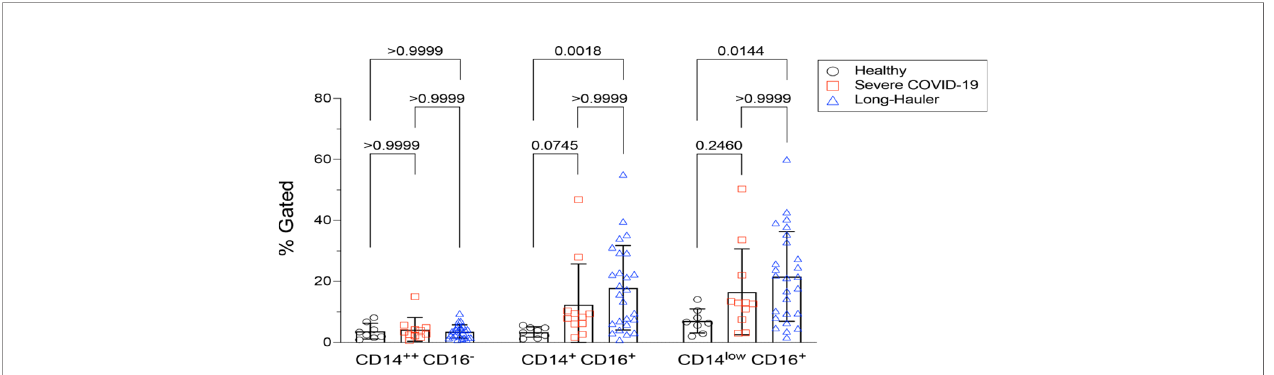
FIGURE 1 | Quanti fi cation of classical, intermediate and non-classical monocytes in PASC (LH). Non-classical monocytes were signi fi cantly elevated in severe COVID-19 and in PASC. Values for each category were based on the parental gating in Supplementary Figure 1 . Statistical analysis was performed using the Kluskal-Wallis test. P values <0.05 are considered signi fi